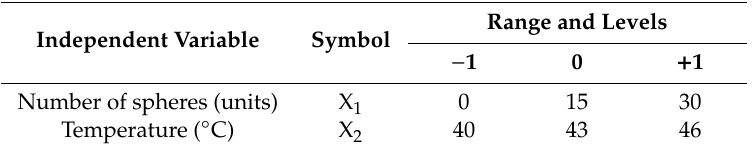
Table 2. Experimental range and levels of the independent process variables (number of glass spheres and temperature) used during the production of ethanol by simultaneous saccharification